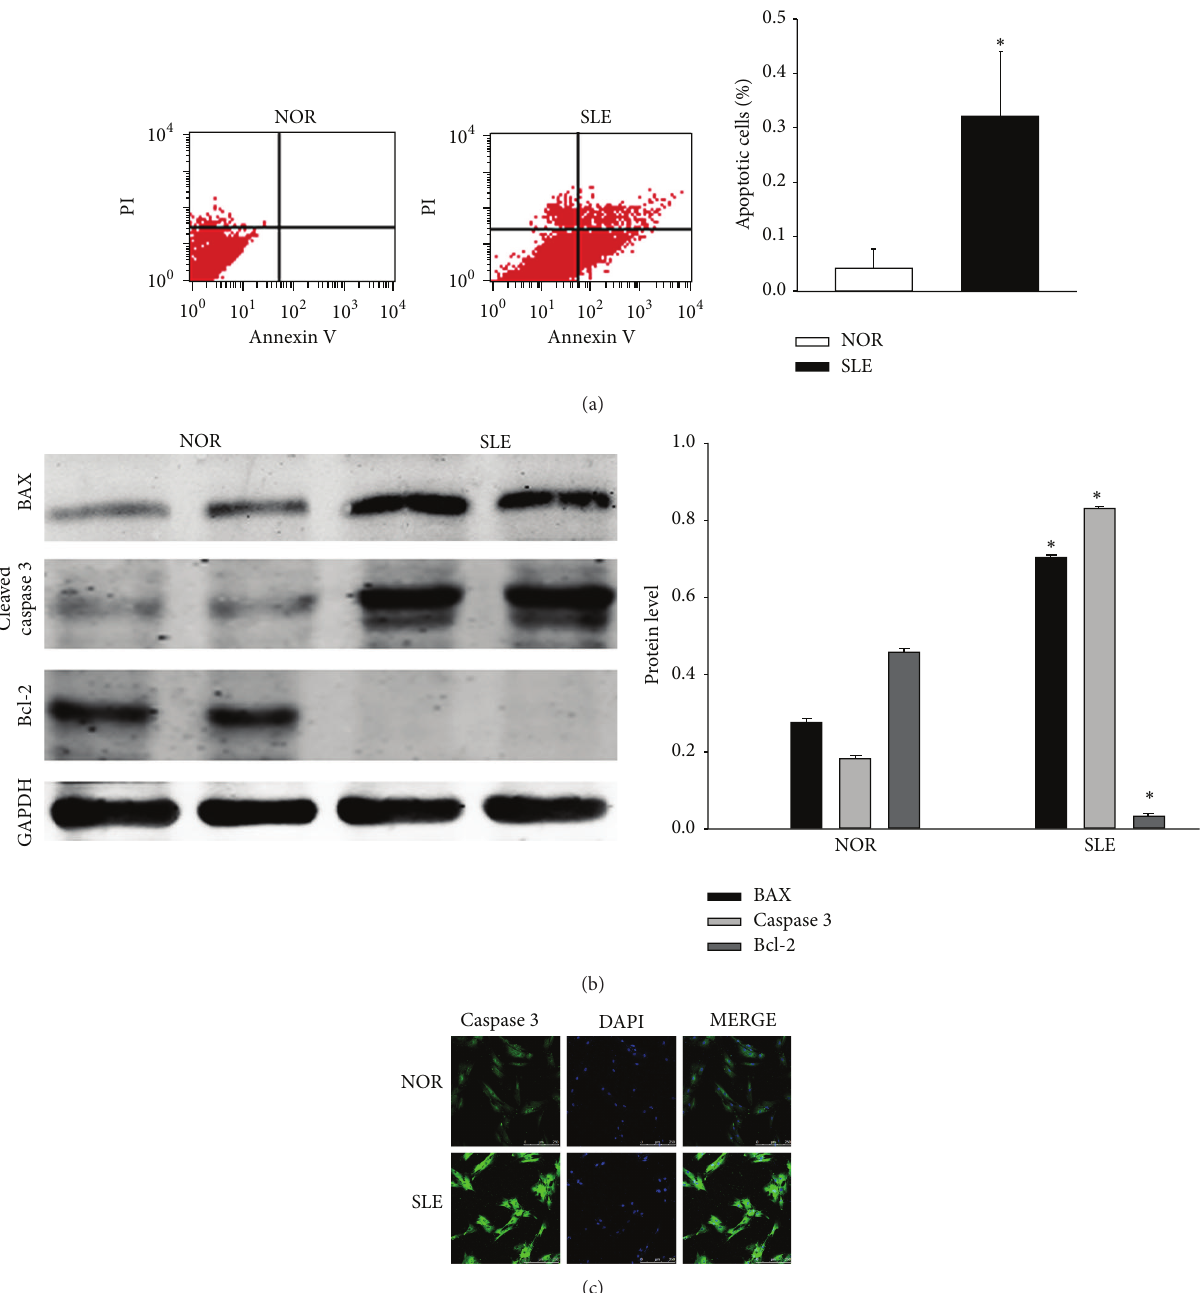
Figure 1: Apoptosis of BMSCs from SLE patients. (a) BM-MSCs at passage 4 were isolated and harvested from SLE patients and normal controls, and analyzed by Annexin V-FITC/PI staining. Annexin V-positive cells were 4.1 ± 3.7% in normal controls, 32.3 ± 12.0% in SLE patients ( 𝑃 < 0.05 ). (b) Western blot analysis of BAX, active caspase-3 and Bcl-2 was performed in BM-MSCs from normal controls and SLE patients. (c) BM-MSCs from normal controls and SLE patients were fixed and stained with antiactive caspase-3. FITC-labeled secondary antibody was used (green fluorescence) Nuclei were stained with DAPI (blue fluorescence). Images were captured by a confocal laser microscope. (Bar represents mean ± SD, ∗ 𝑃 < 0.05 compared with the normal